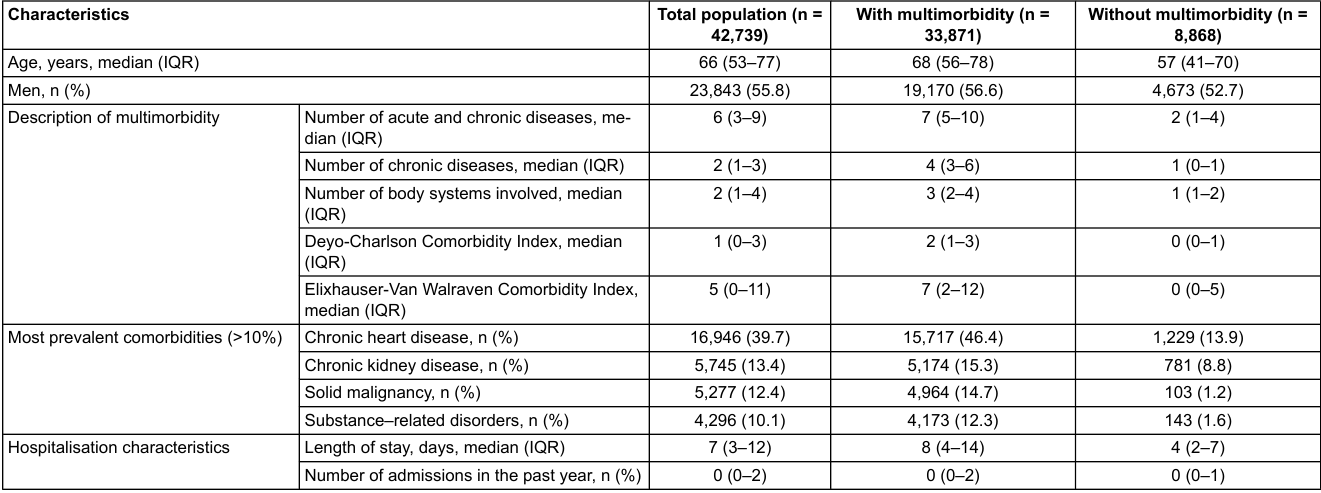
Table 1: Baseline characteristics.